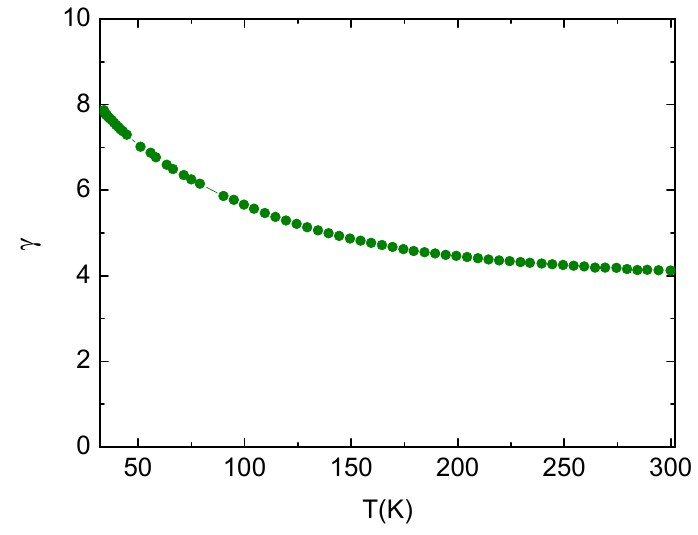
Figure 5. The temperature dependence of normal state anisotropy γ = (cid:112) ρ